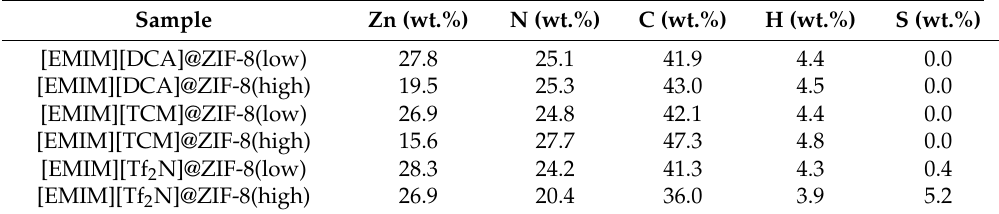
Table A1. Elemental mass percentages obtained from ICP-AES and Elemental Analysis for prepared composites.